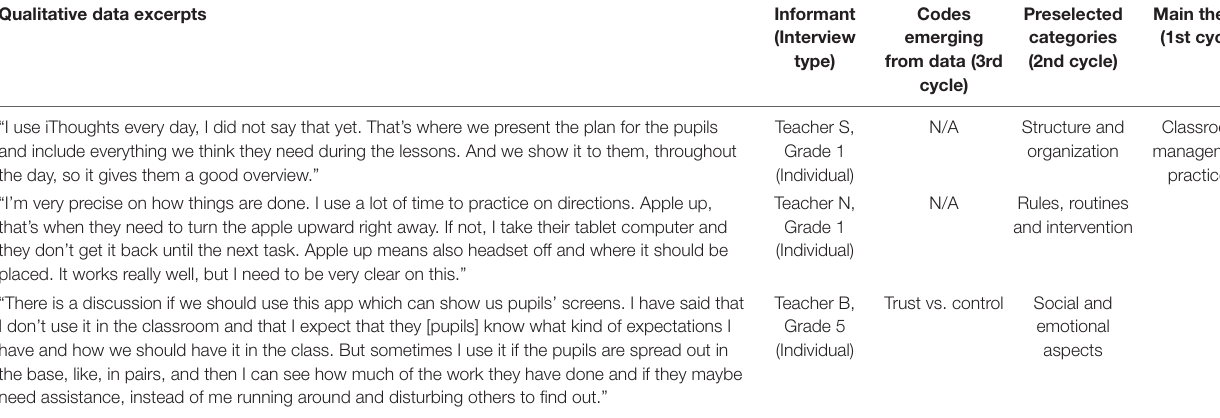
TABLE 2 | Example of qualitative interview data coding: classroom management practices. Qualitative data